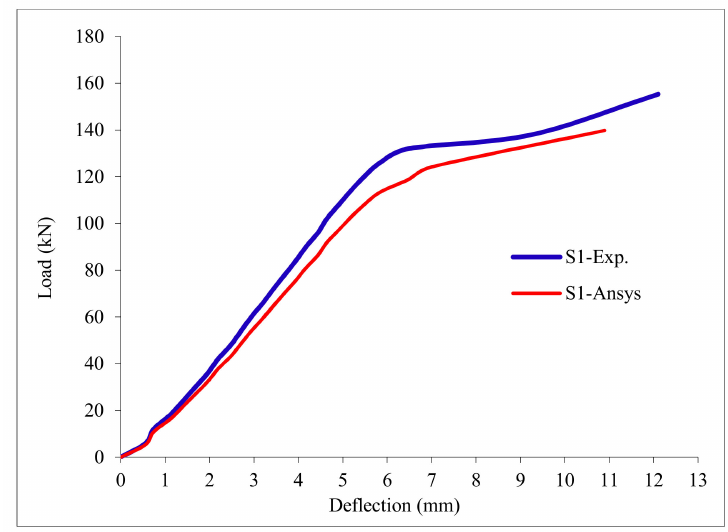
Figure 26. Load deflection curve for control slab S1.